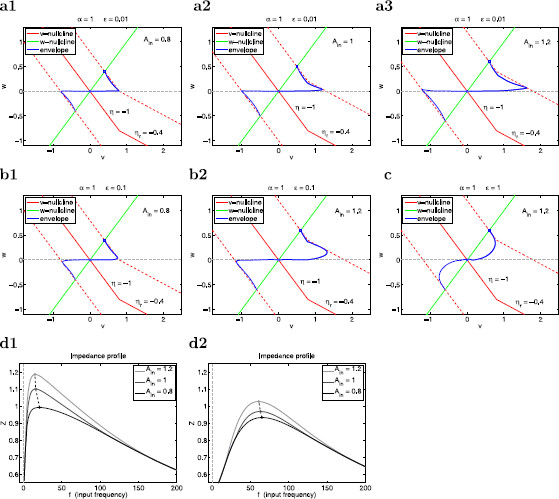
Voltage response of the PWL system (37)–(38) with hv and hw given by (39) to sinusoidal inputs. a–c Envelope-plane diagrams for representative values of Ain and ϵ. a1Ain=0.8, ϵ=0.01. a2 Ain=1, ϵ=0.01. a3Ain=1.2, ϵ=0.01. b1Ain=0.8, ϵ=0.1. b2Ain=1.2, ϵ=0.1. cAin=1.2, ϵ=1. d Impedance profiles for representative values of Ain and ϵ. d1ϵ=0.01. d2ϵ=0.1. We used the following parameters: α=1, η=−1, ηr=−0.4, vc=0.8